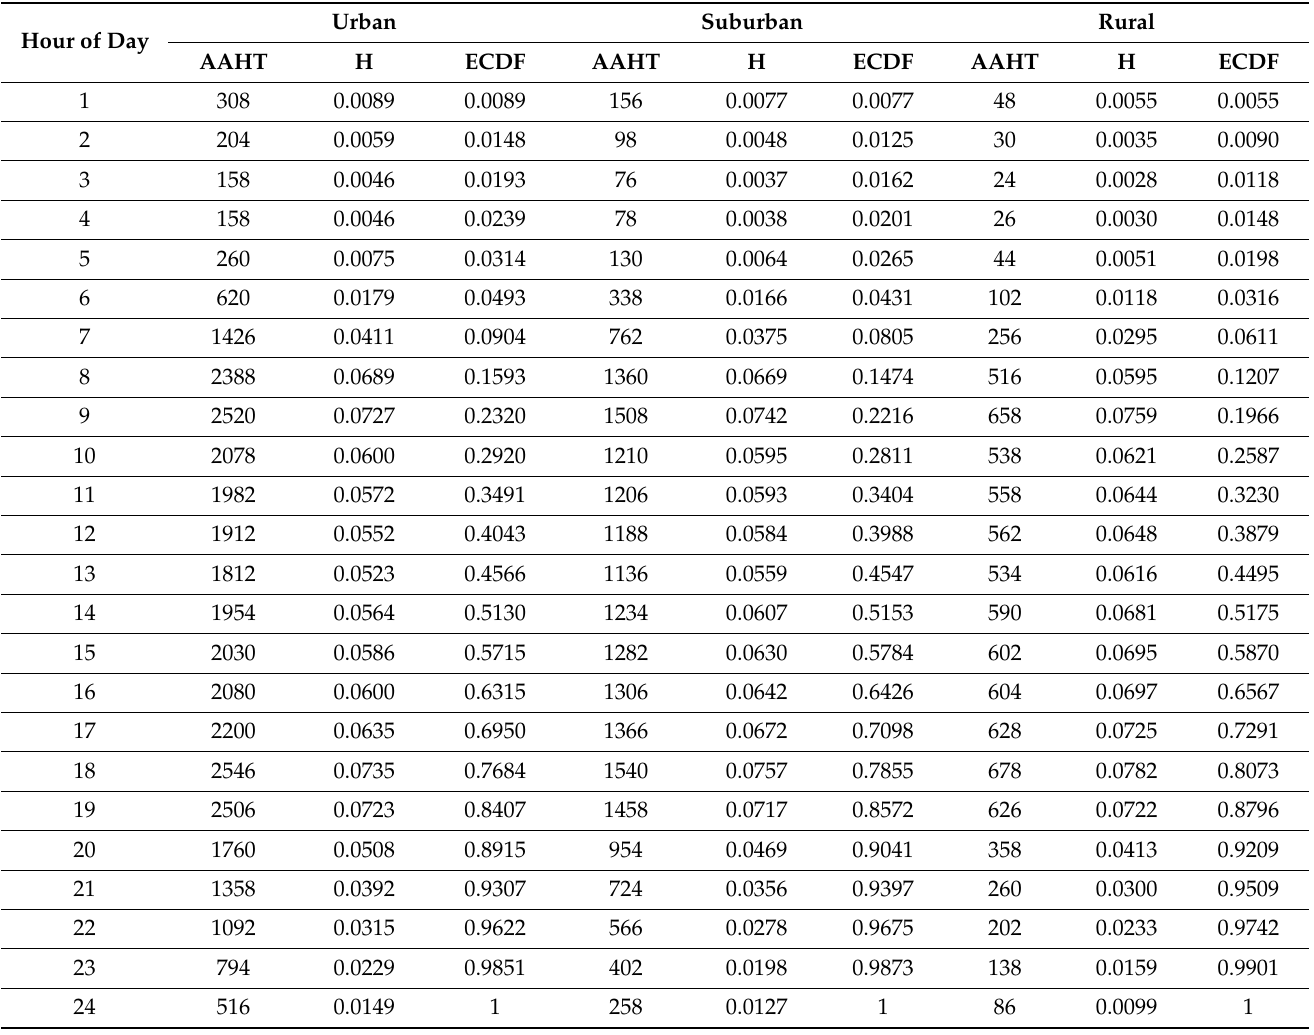
Table 7. Annual average hourly traffic volumes, annual average hourly traffic volume ratios to AADT, and ECDFs of each